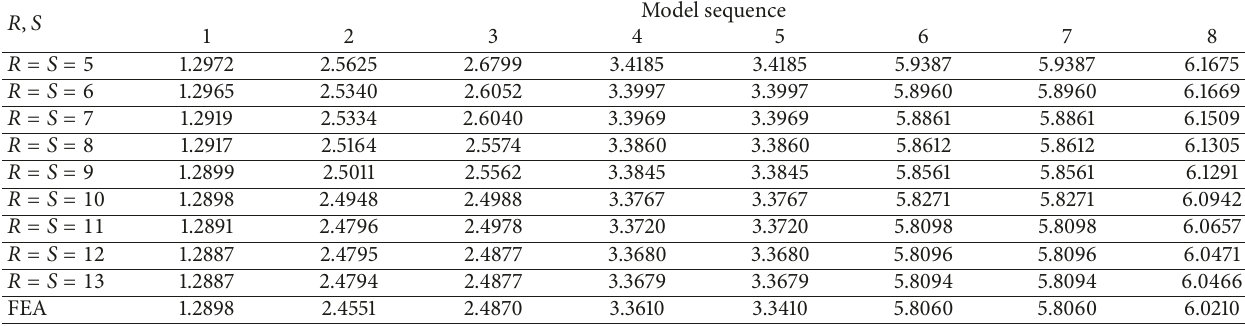
= 𝜉 = 10 4 , 𝜉 = 0 , for 𝐾 𝑖 𝐾 𝑖𝑗 𝑖